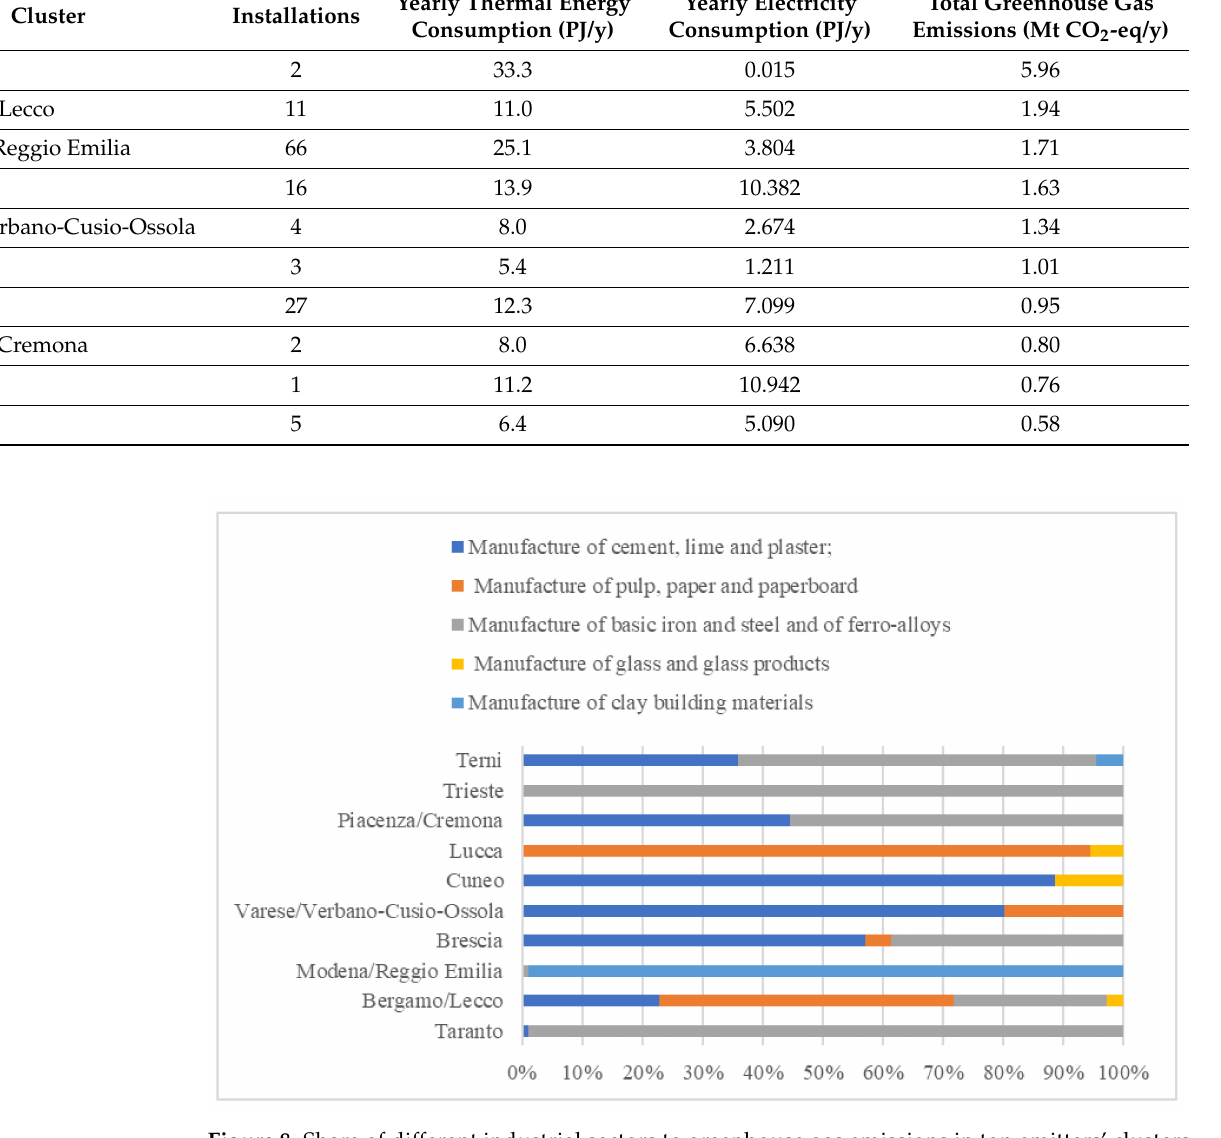
Figure 8. Share of different industrial sectors to greenhouse gas emissions in top emitters’ clusters (top emitters increase from top to